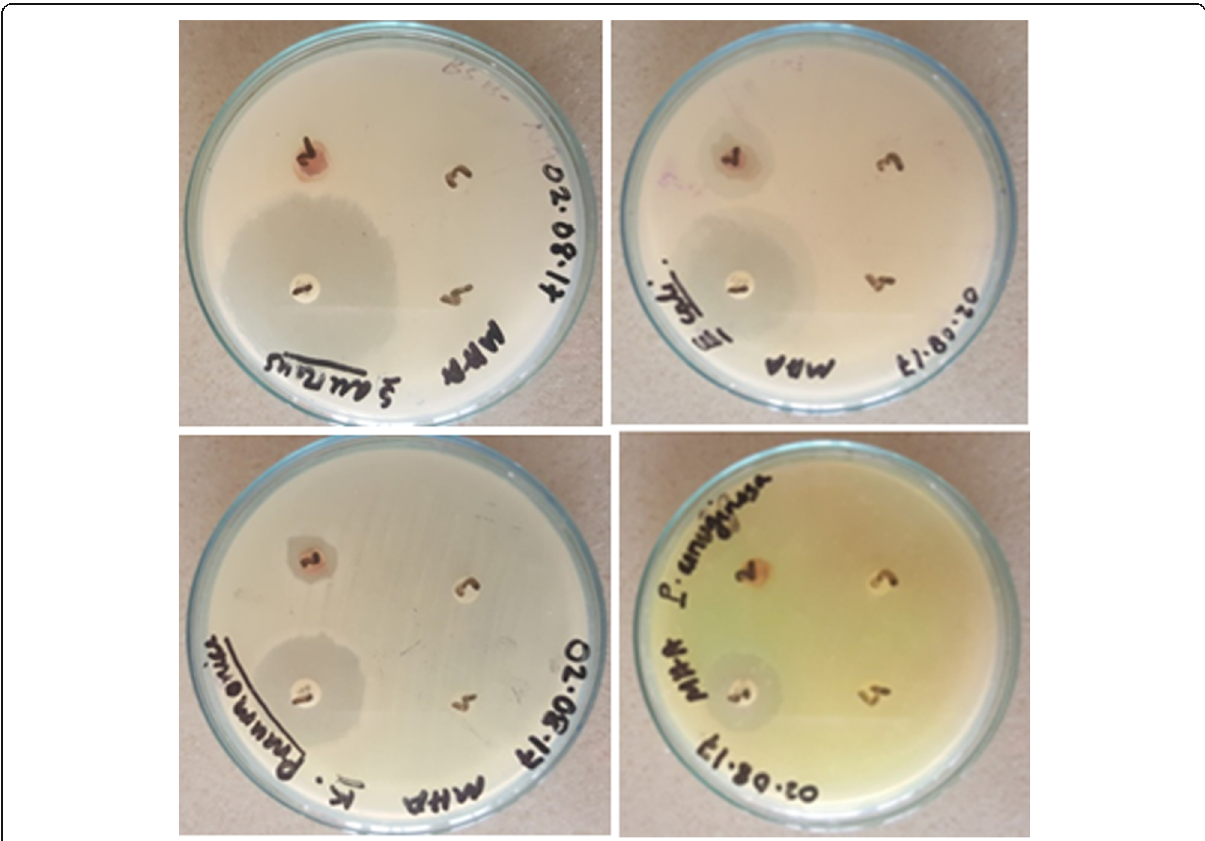
Fig. 5 Zone of inhibition of D. malabarica extract for different gram positive and gram negative bacterial